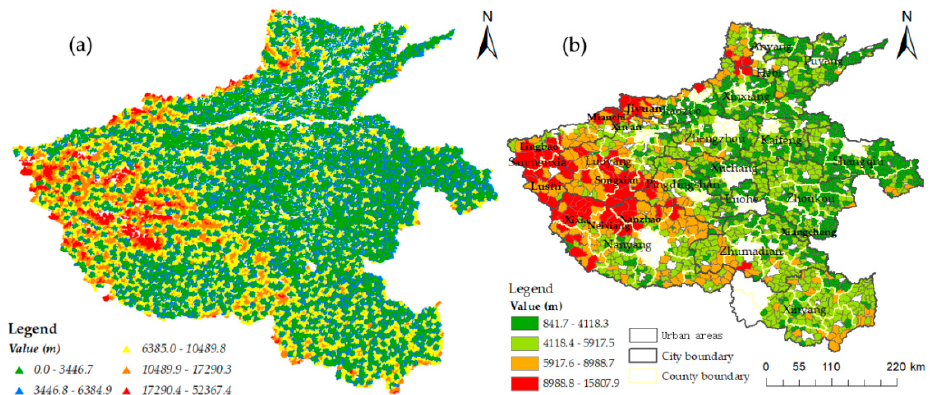
Figure 3. Medical accessibility in rural areas of Henan Province: ( a ) distance cost of medical treatment in villages; ( b ) spatial distribution of medical accessibility in townships.